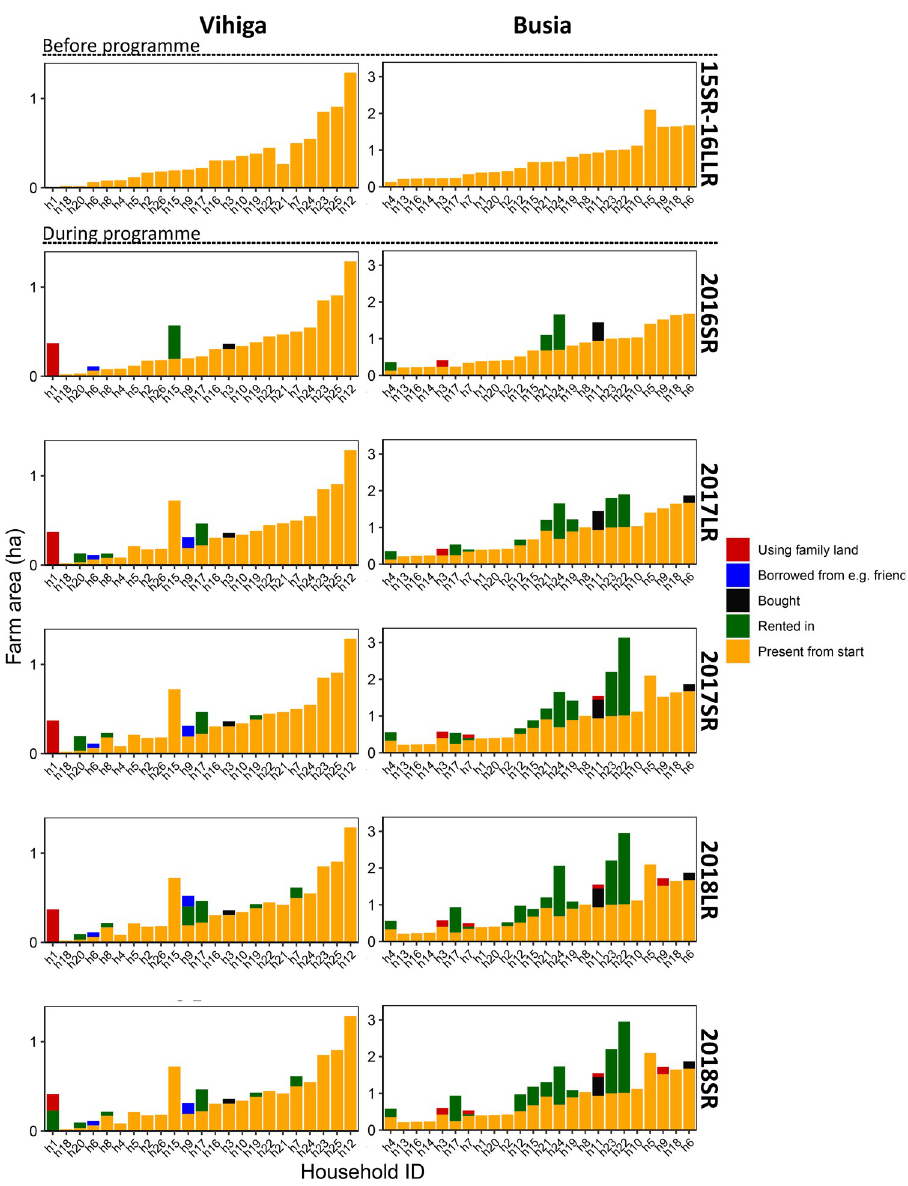
Fig 3. Farm area per household. Households were ordered according to their reported farm area in 2016LR, before the first season of the voucher programme. Some fields were reported in later seasons, while they were already owned in